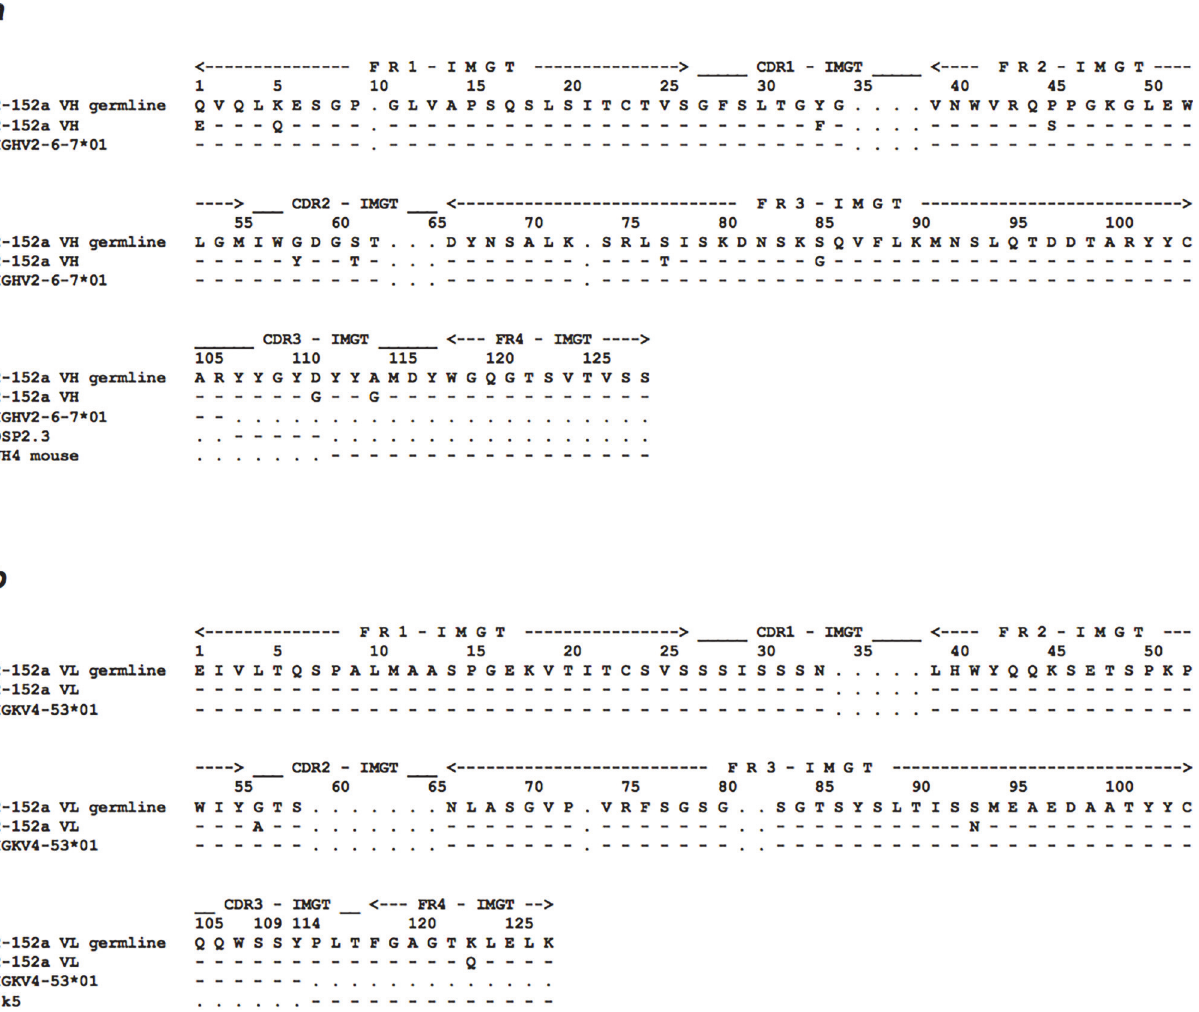
Fig 2. Identification of the surface DHCR24-recognition domain of 2-152a MAb. ( a ) Alignment of the VH amino acid sequence of 2-152a MAb with the germline configuration. The V, D, J, and CDR sequences were determined by using the IMGT database (http://www.imgt.org/). ( b ) Alignment of the VL amino acid sequence of 2-152a MAb with the germline configuration. The V, J, and CDR sequences were determined by using the IMGT